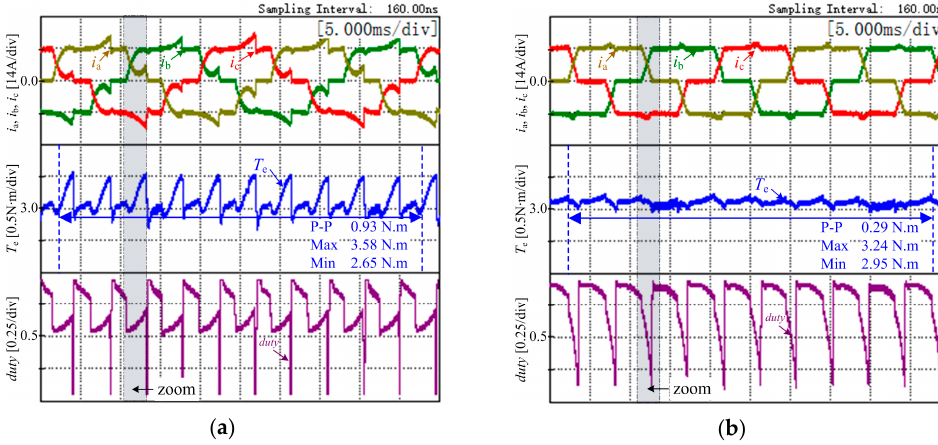
Figure 10. Experimental waveforms under the rated load at 550 r/min. ( a ) the traditional strategy. ( b ) the proposed strategy.